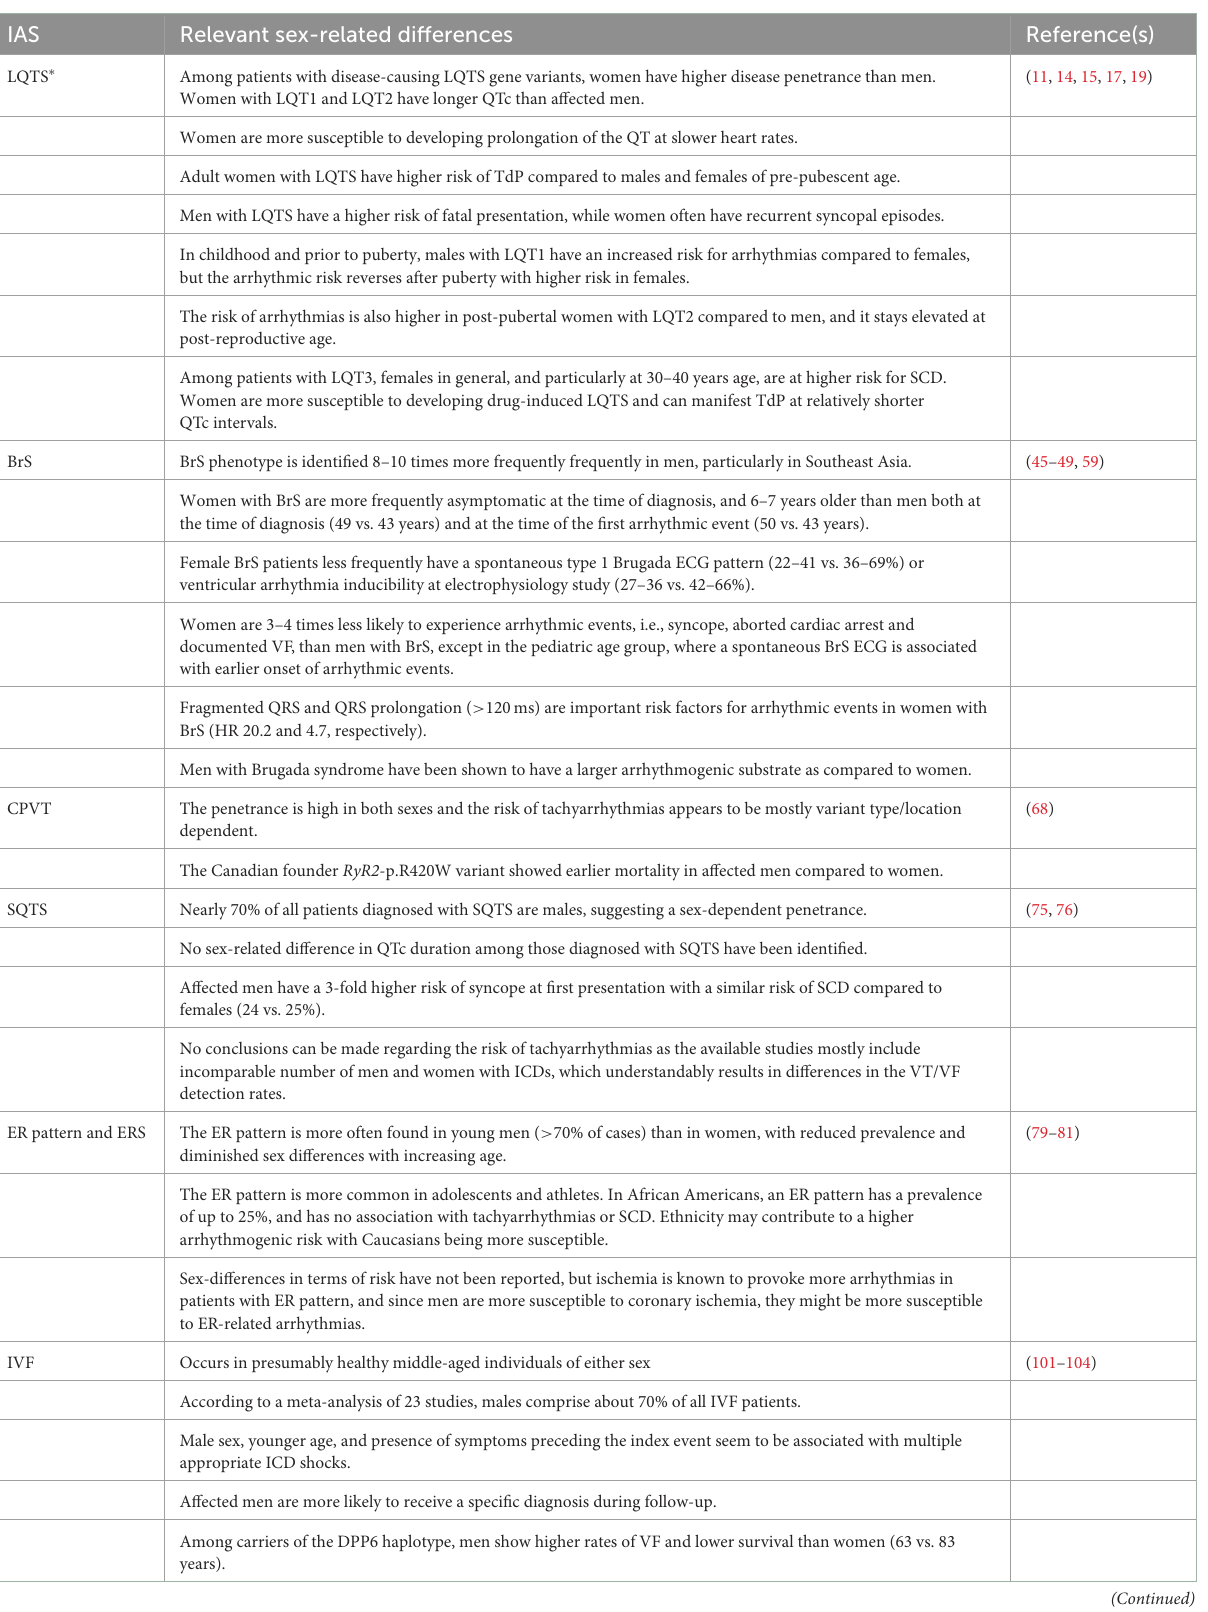
TABLE 1 Summary of sex-related differences in inherited arrhythmia